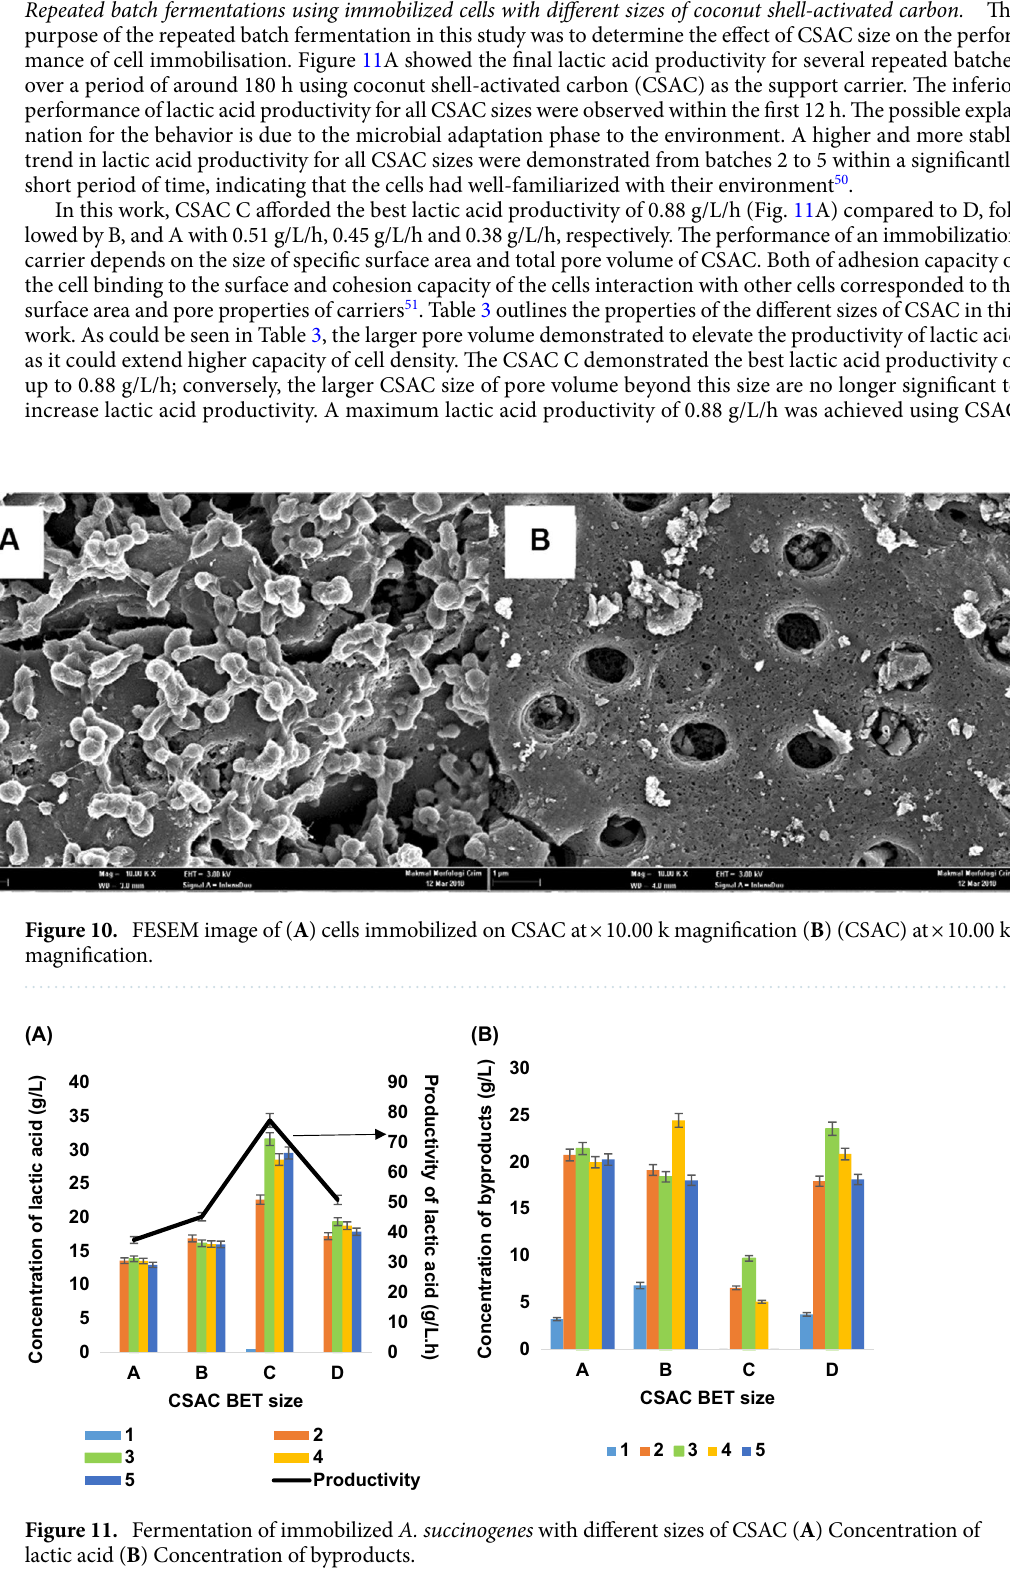
Figure 11. Fermentation of immobilized A. succinogenes with different sizes of CSAC ( A ) Concentration of lactic acid ( B ) Concentration of